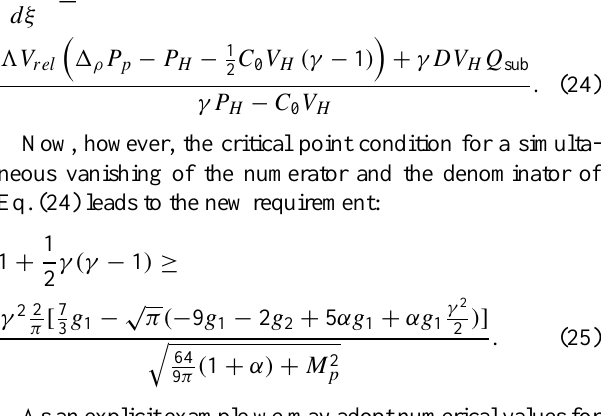
Fig. 4. Shown as a function of the plasma wall coordinate x = z/D , with D = 100AU being the linear extent of the plasma wall, is the H-atom bulk velocity V H in units of [km/s] (left ordinate) h i and the H-atom pressure P H in units of 10 − 13 dyne/cm 2 (right ordinate) calculated on the basis of the characteristic Eq. (24) for various values of the parameter 3 = Dσ rel n p . The H-atom flow in all cases enters the plasma wall at x = 0 with a velocity of V H ( 0 ) = 25 km/s. The value α = T H /T p in all cases is set equal to